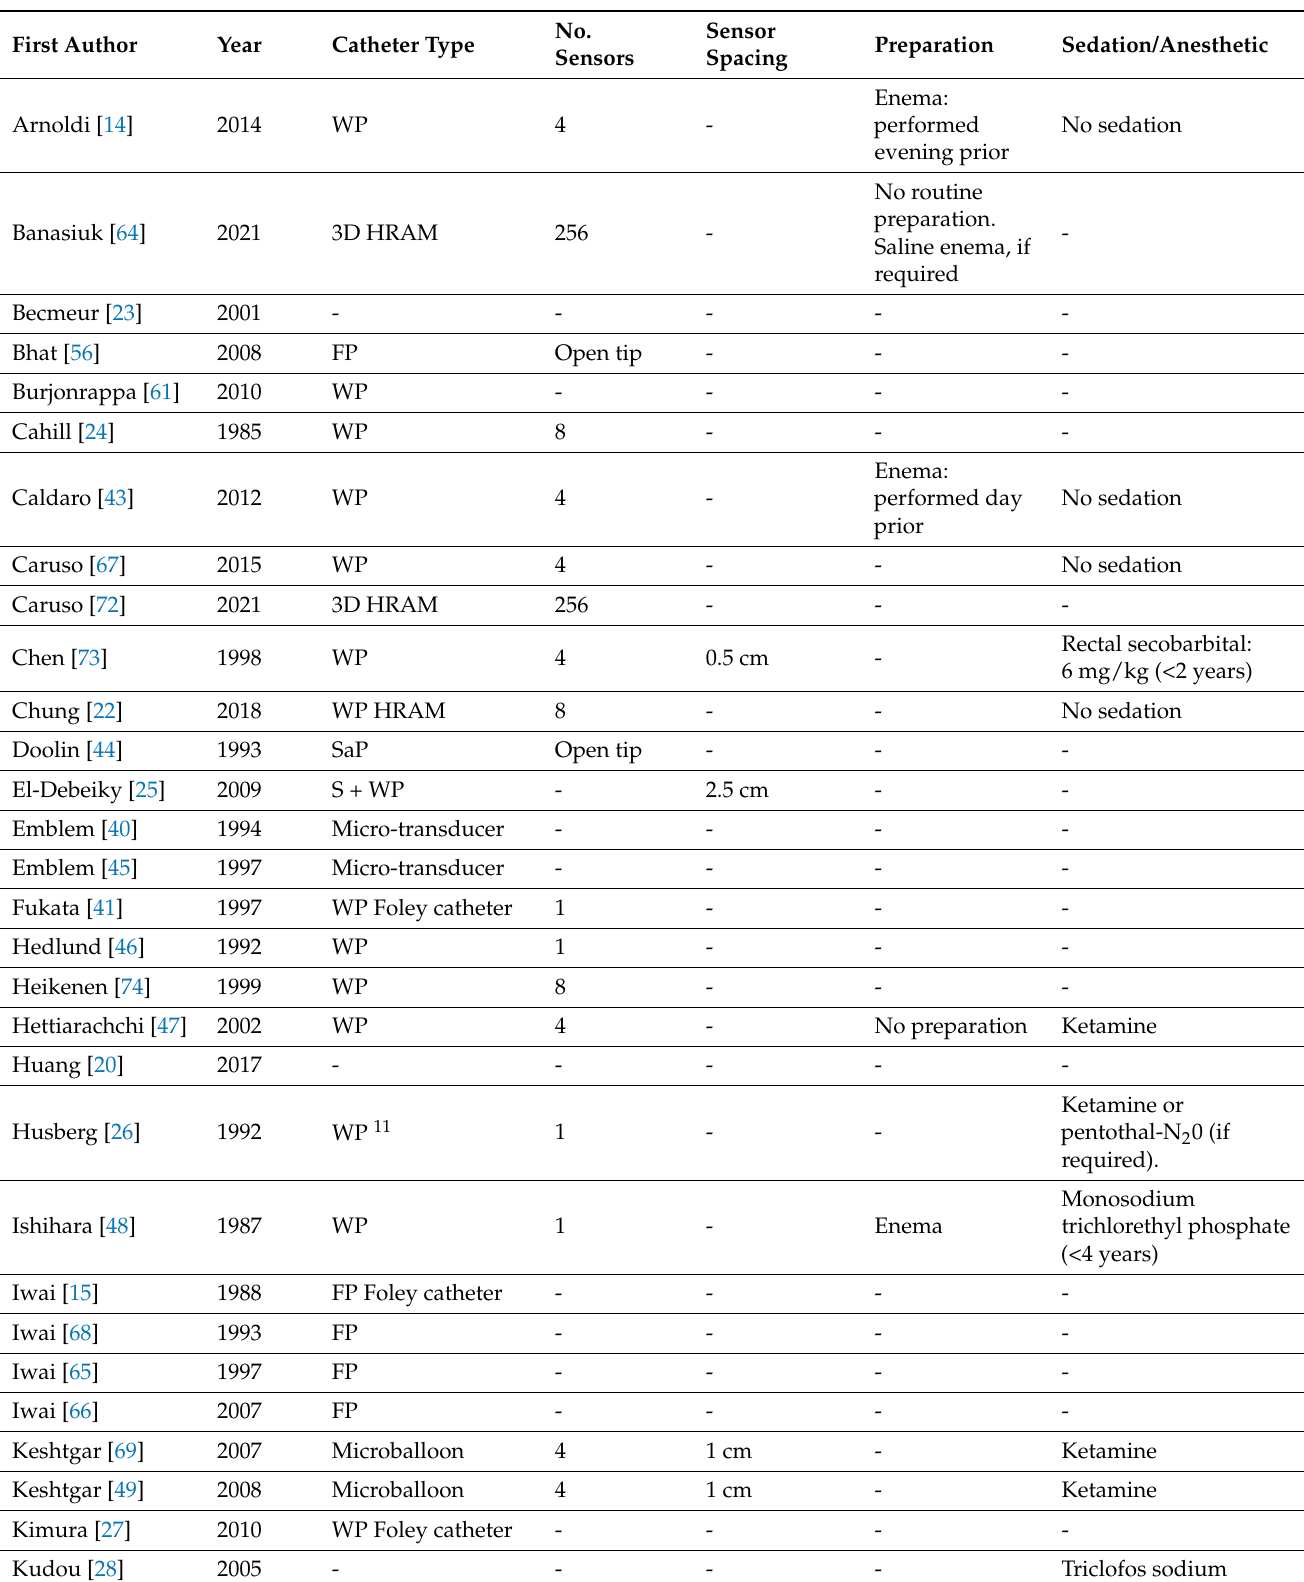
Table 2. Summary of reported anorectal manometry